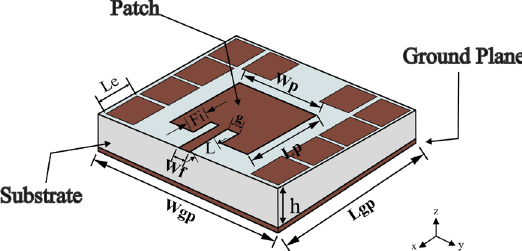
Figure 1. Antennas design with EBG